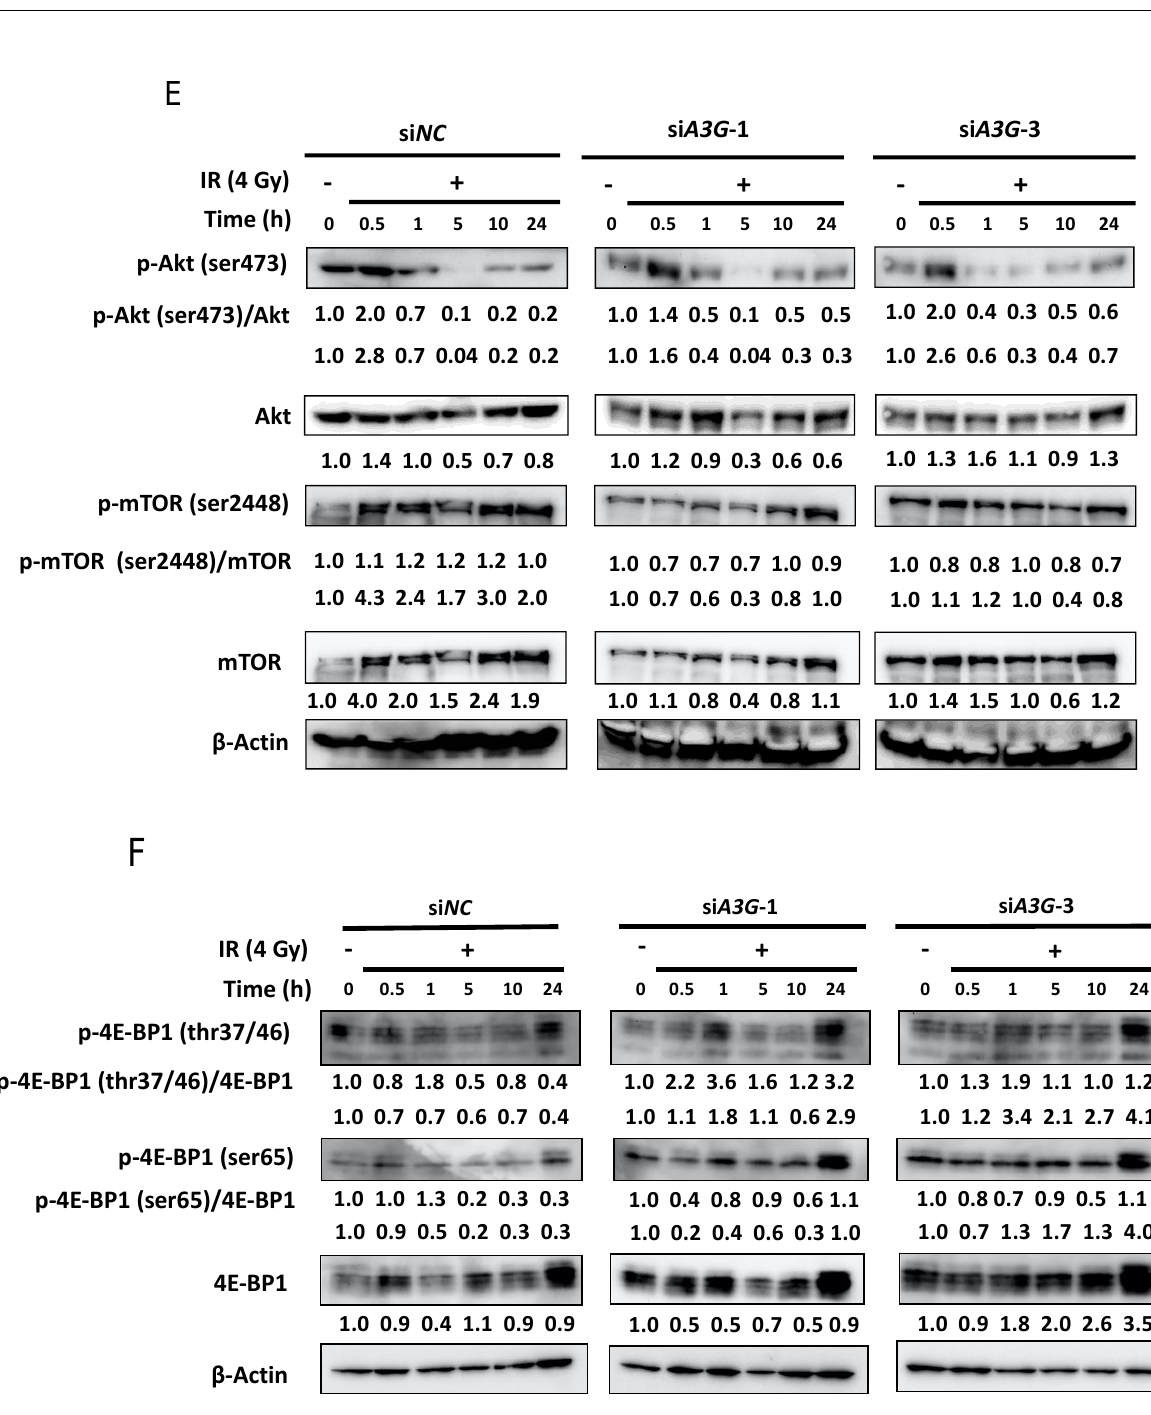
Figure 2. Radiosensitization effects of A3G knockdown on pancreatic cancer MIAPaCa2 cells and changes in cell cycle distribution and DNA damage response pathway. ( A ) The effect of A3G knockdown by a different siRNA (si A3G-3 ) on radiosensitization in pancreatic cancer MIAPaCa2 cell line after γ -irradiation by colony formation assay. ( B ) Effects of two different siRNAs (si A3G-1 and si A3G-3 ) on cell cycle distribution 24 h after γ -irradiation. Asterisks show p < 0.05. ( C – F ) Effect of si A3G-1 and si A3G-3 on the expression of proteins related to DDR and cell proliferation using Western blot analysis. Relative expression levels of proteins first normalized by β -actin, then normalized again to no irradiation controls are shown under each panel. In ( C ), the values of normalization for siA3G-1 are obtained by comparison with the second left-most lane in the left-most panel and shown with underlines. In addition, for phosphorylated proteins, the ratio of the phosphorylated protein/total protein was shown as indicated for ( D – F ).